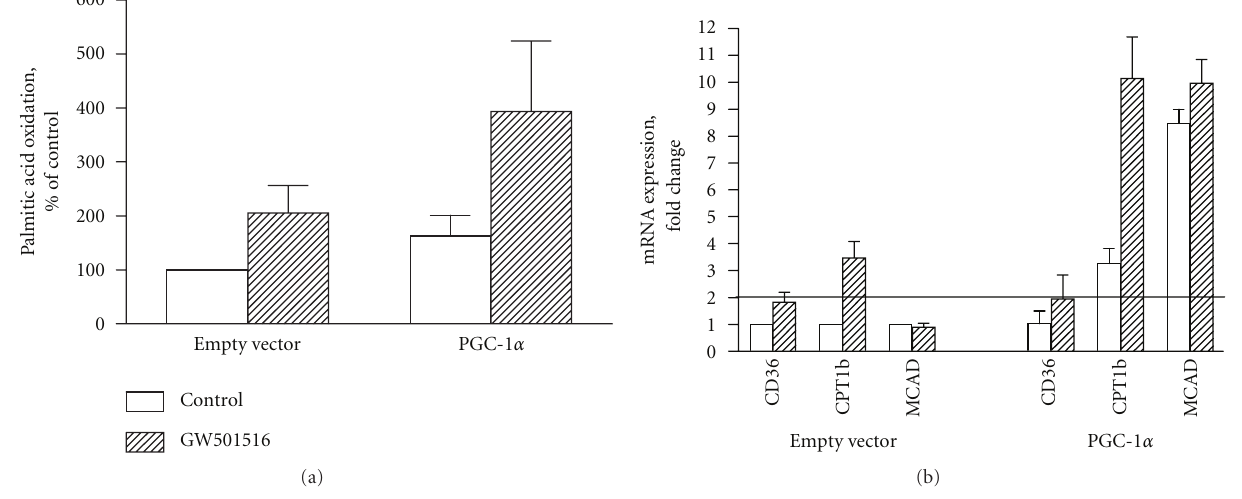
Figure 5: E ff ects of GW501516-treatment in human myotubes overexpressing PGC-1 α on palmitic acid oxidation (a) and mRNA levels of genes involved in lipid and glucose metabolism (b). Myotubes infected with either empty vector or PGC-1 α were treated with 10nM GW501516 or control (0.1% DMSO) for 48h. (a): The cells were incubated with 1mL/well of [ 3 H]palmitic acid and assayed for labeled acid soluble metabolites (ASM), as described in Section 2. Values are presented as means ± SEM ( n = 2 experiments, each representing one donor, with 3 replicates each). (b): mRNA expression was assessed by RT-PCR as described in Section 2. Values are presented as means ± SEM ( n = 2 experiments, each representing one donor, with 3 replicates each), normalized to the levels of housekeeping gene 36B4 in control cells infected with empty vector and treated with DMSO. A fold change ≥ 2 or ≤ 0.5 was considered an increase or decrease in expression level,